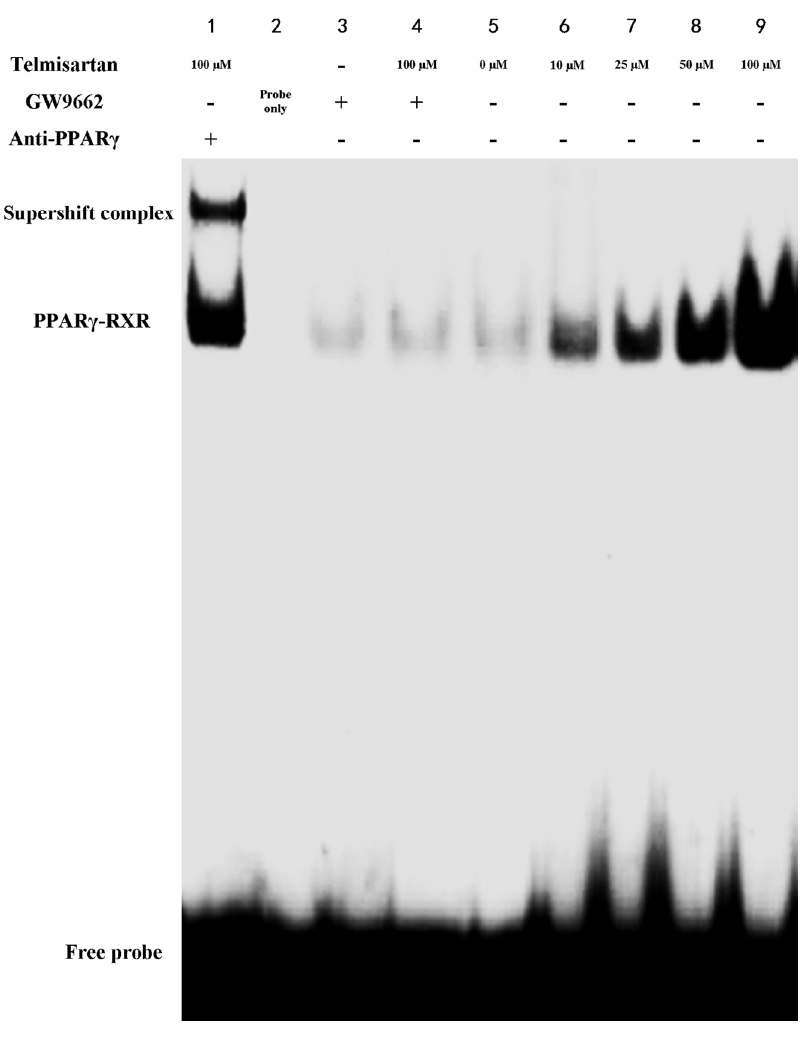
Figure 7. Telmisartan increases DNA binding activity of PPAR γ in A549 cells. DNA binding activity of PPAR γ in A549 cells treated with 4 concentrations of telmisartan (10, 25, 50 and 100 μ M) or GW9662 (10 μ M) for 48 h were examined by EMSA. ( 1 ) Nuclear extracts from 100 μ M telmisartan + oligonucleotide probe + anti-PPAR γ antibody; ( 2 ) oligonucleotide probe only; ( 3 – 9 ) Nuclear extracts from corresponding group + oligonucleotide